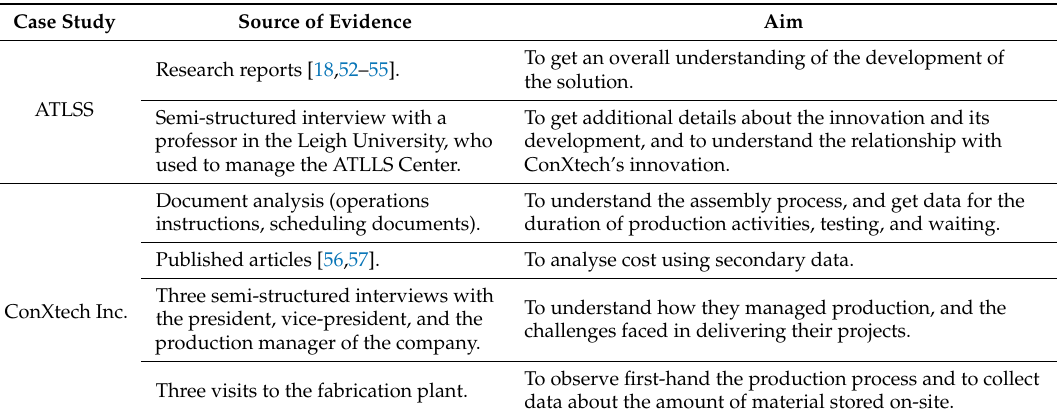
Table 1. Sources of evidence for case